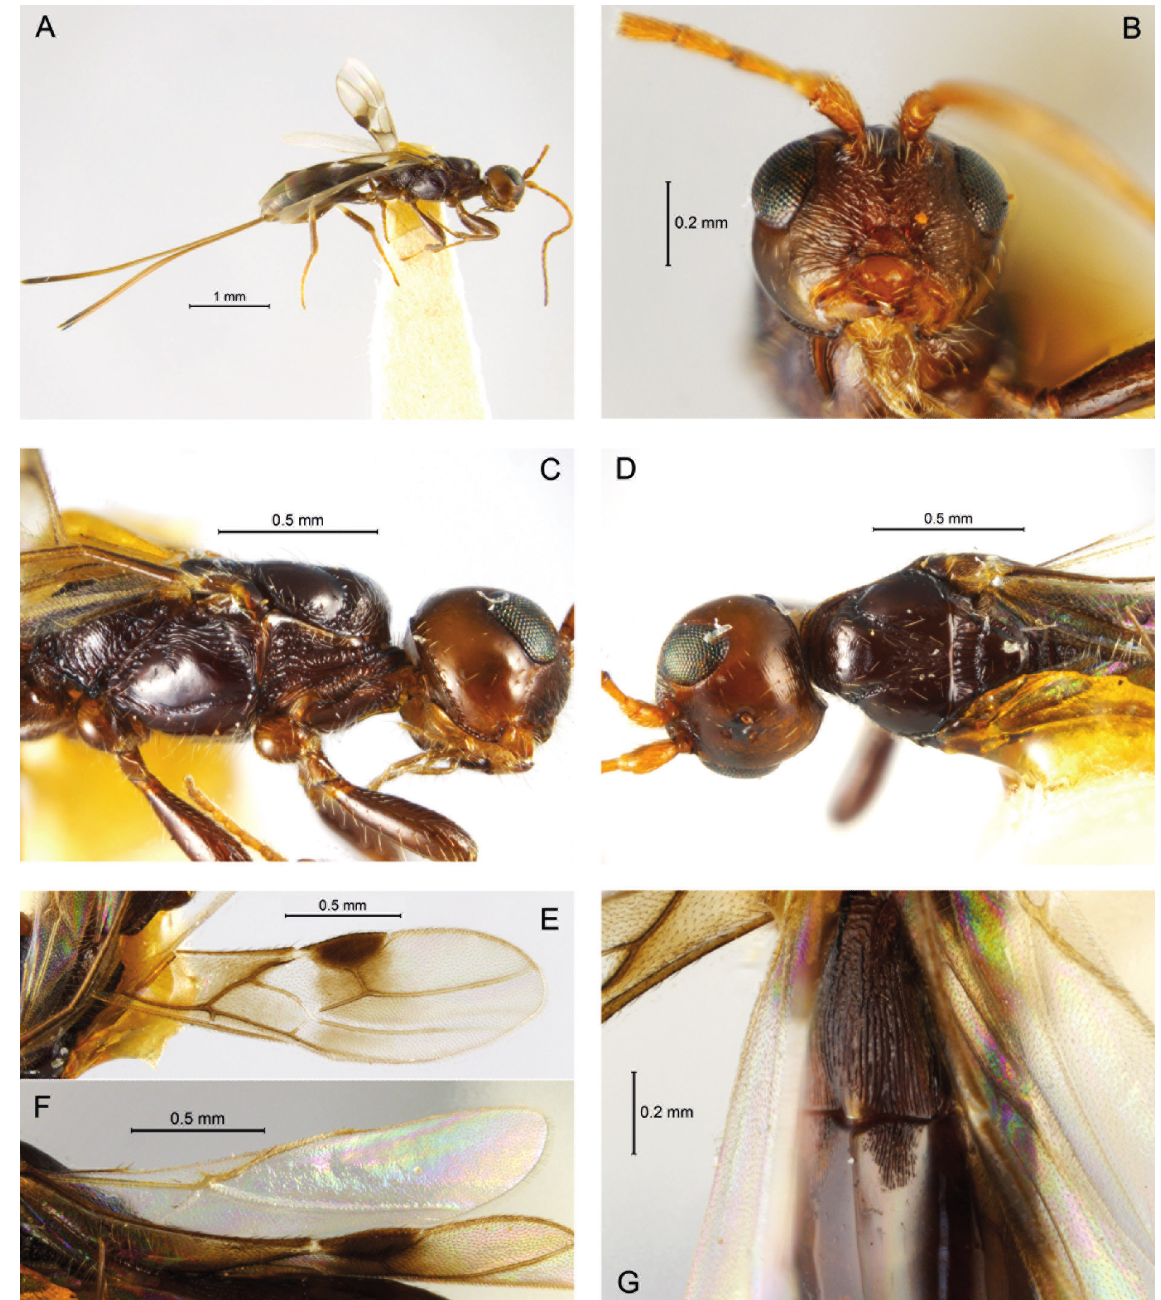
Fig. 2. Hecabolus chrisaxeli sp. nov., ♀, holotype (NHMUK). A . Habitus, lateral view. B . Head, frontal view. C . Mesosoma, lateral view. D . Mesosoma, dorsal view. E . Fore wing. F . Hind wing. G . Metasoma, dorsal